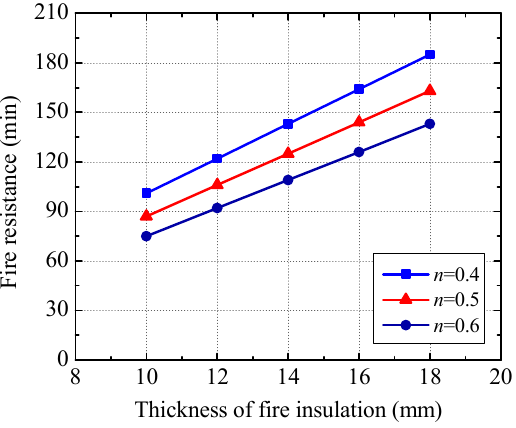
Figure 28. Variation of fire resistance with thickness of fire insulation (without longitudinal reinforcements).